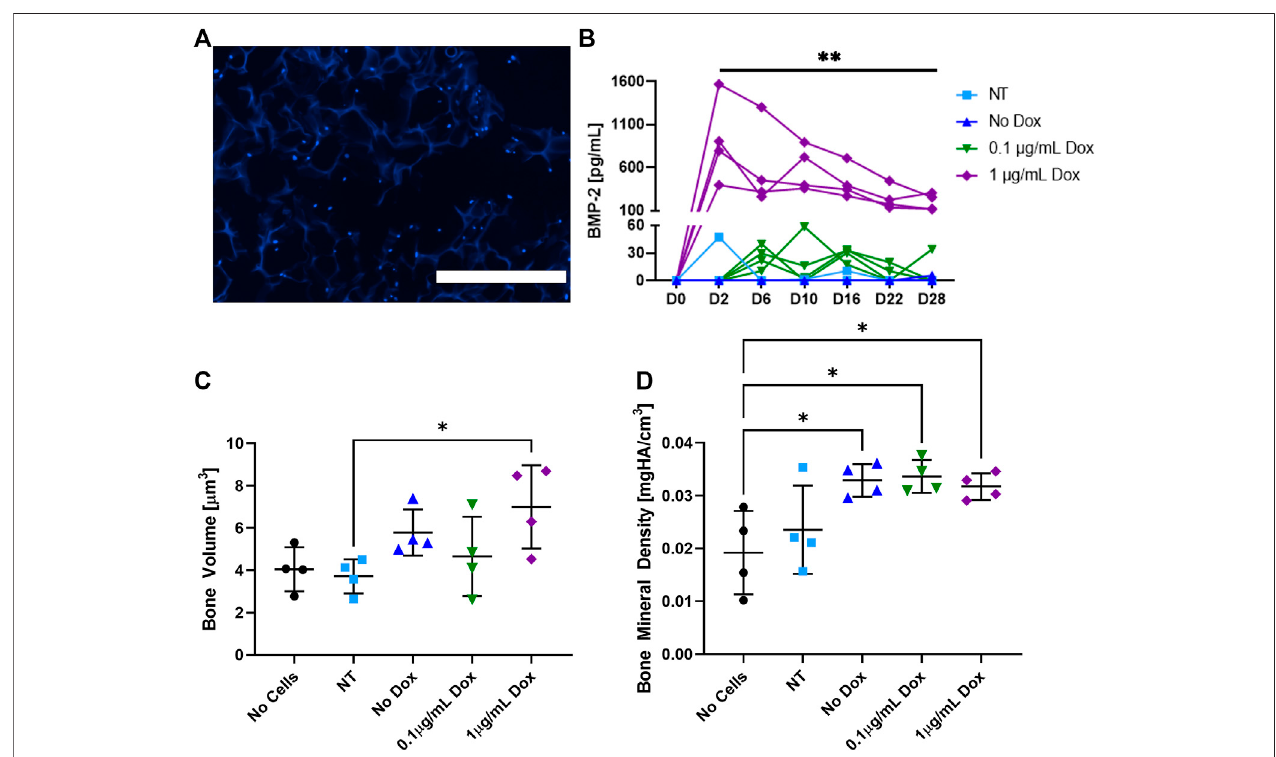
FIGURE2| Invitro analysisofthecell-seededcryogelscaffolds. (A) RepresentativeDAPI(blue)stainingdemonstratestheADSCsin fi ltratedthroughoutthecryogel scaffold after 6 days of culture. (B) Measured by an ELISA, BMP-2 production was induced in transduced cells treated with 1 μ g/ml of dox over 28 days, whereas non- transduced (NT) cells, transduced cells that did not receive dox, and transduced cells that only received 0.1 μ g/ml of dox had statistically lower ( p < 0.01) BMP-2 production. In transduced cells treated with 1 μ g/ml of dox, (C) mineralized volume and (D) bone mineral density were signi fi cantly higher than those of non- transduced cells and acellular scaffolds, respectively ( p < 0.05). The white scale bar denotes 400